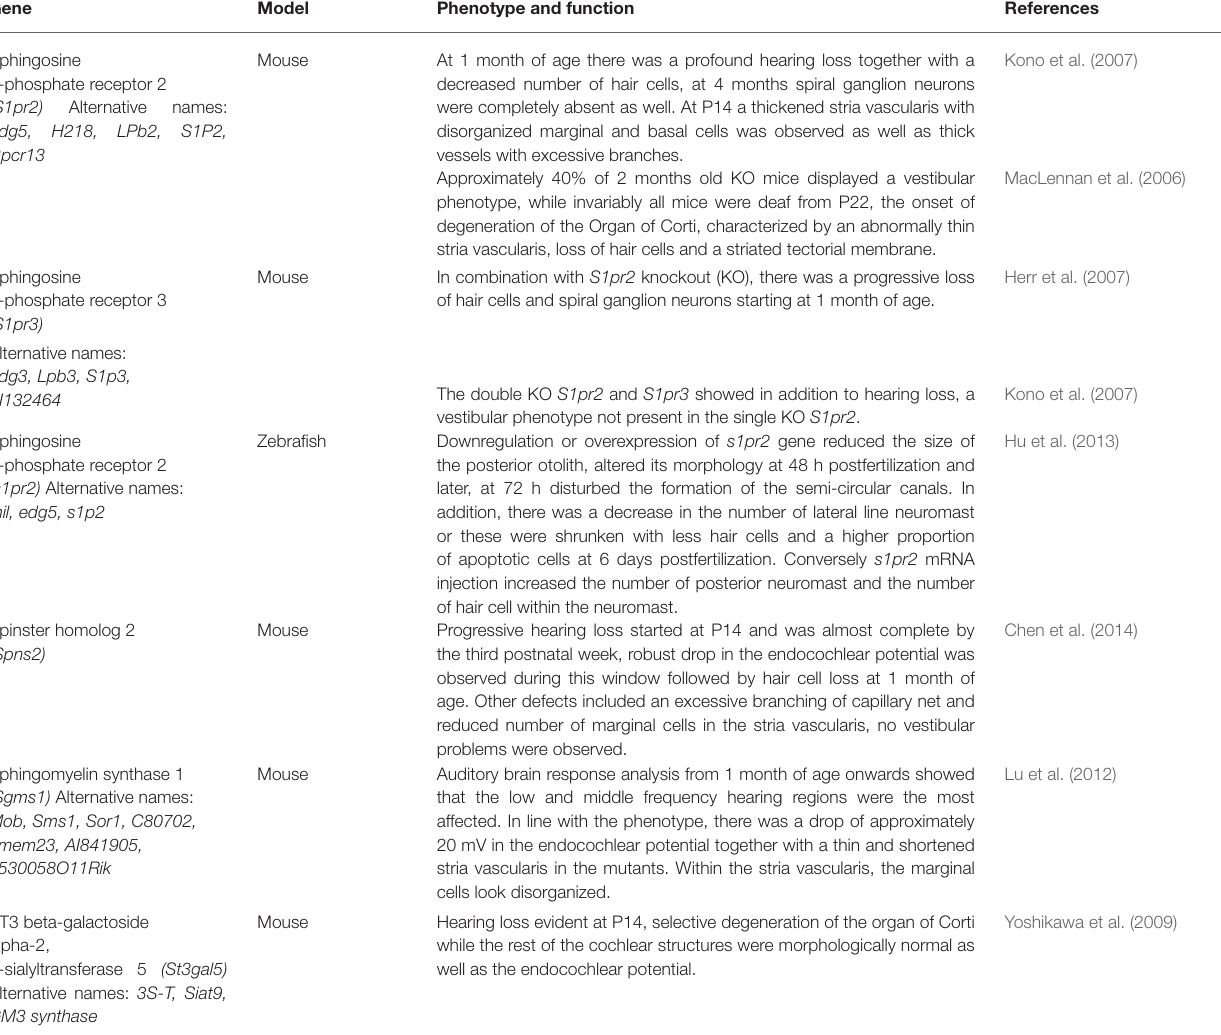
TABLE 1 | Knockout models for genes involved in sphingolipid metabolism and signaling have been found to present inner ear defects . Gene